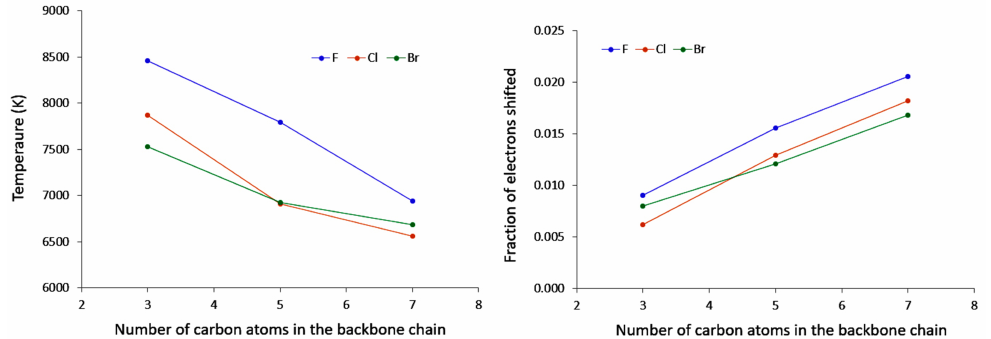
Figure 9. Evolution of the polarisation temperature and the fraction of electron shifted with respect to the number of carbon atoms in the backbone chain when the carbon neighbour to the halogen is perturbed.